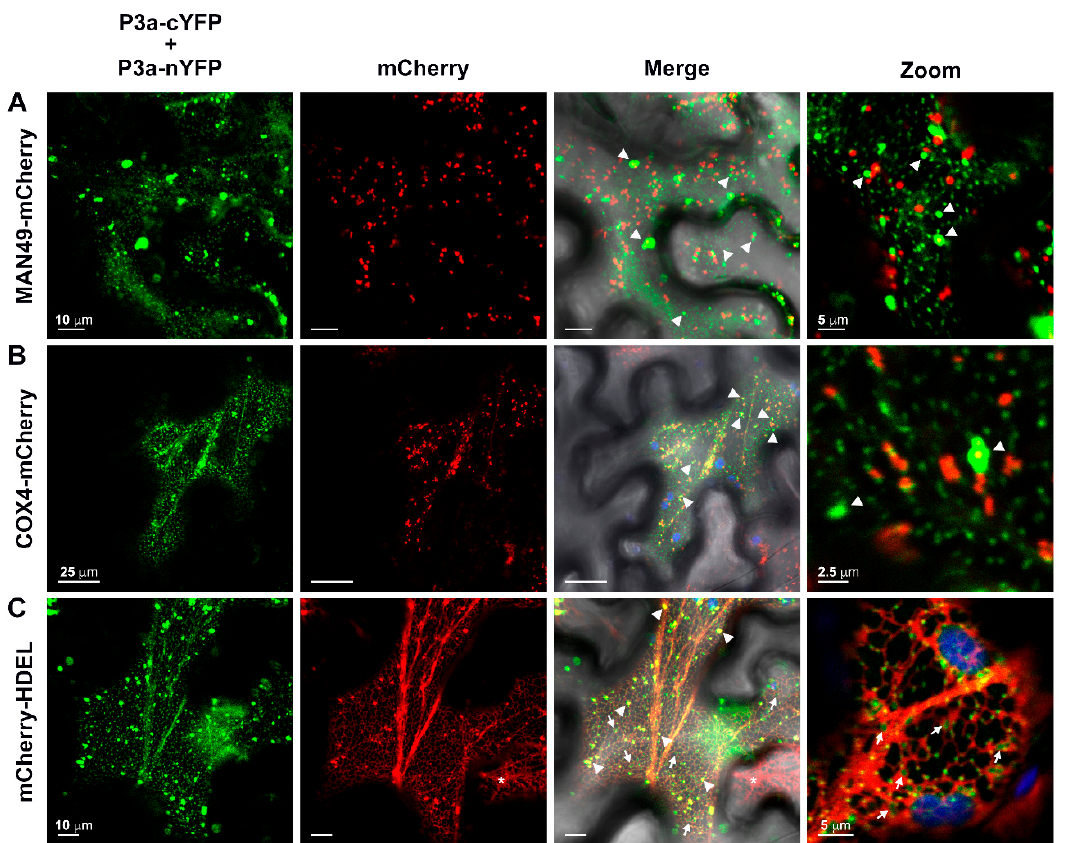
Figure 7. The C-terminally-tagged P3a homodimer localizes to structures associated with the endoplasmic reticulum. The panels represent single-plane confocal micrographs of N. benthamiana leaf epidermal cells co-expressing the bimolecular fluorescence complementation (BiFC) constructs P3a-cYFP plus P3a-nYFP with ( A ) the cis -Golgi marker MAN49-mCherry; ( B ) the inner mitochondrial membrane marker COX4-mCherry; or ( C ) the mCherry-HDEL, which labels the endoplasmic reticulum (ER) network. The overlap of YFP (green) and mCherry (red) fluorescence images with the corresponding brightfield image is shown in the column labeled merge with co-localization appearing yellow. The column marked Zoom is a magnification of a selected region from the merged image within the same panel. White arrowheads highlight large YFP fluorescent aggregates while arrows mark regions of diffuse YFP single localized in the space between ER tubules. A white asterisk indicates a cell expressing mCherry-HDEL only. Chloroplast autofluorescence is highlighted in blue. Scale bars show the length indicated.